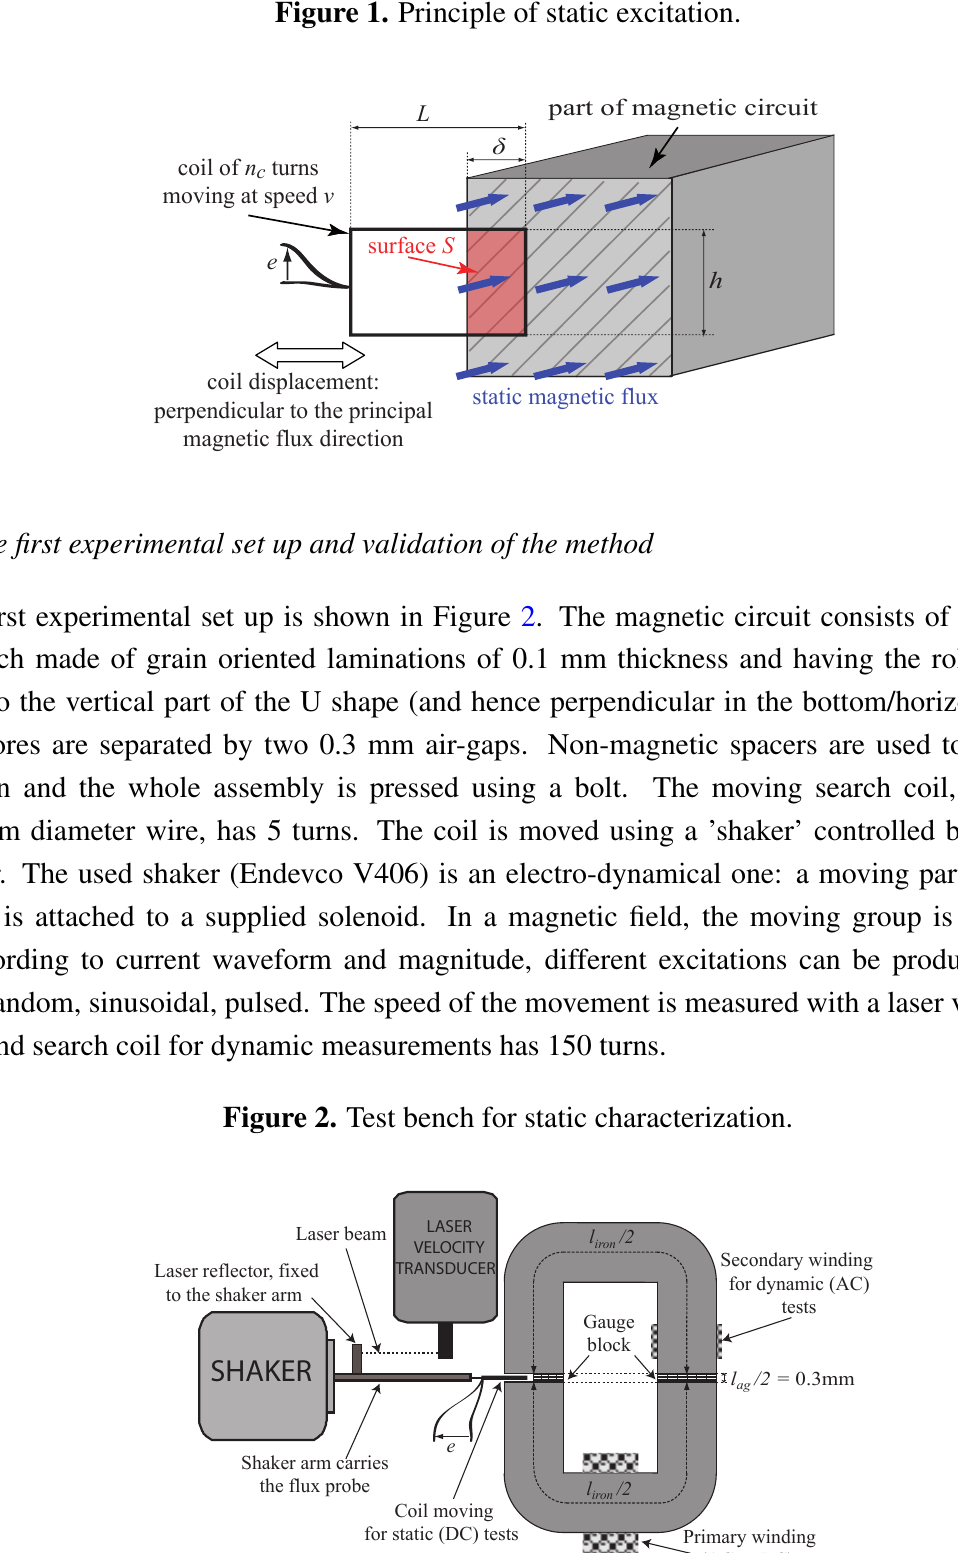
Figure 1. Principle of static excitation.